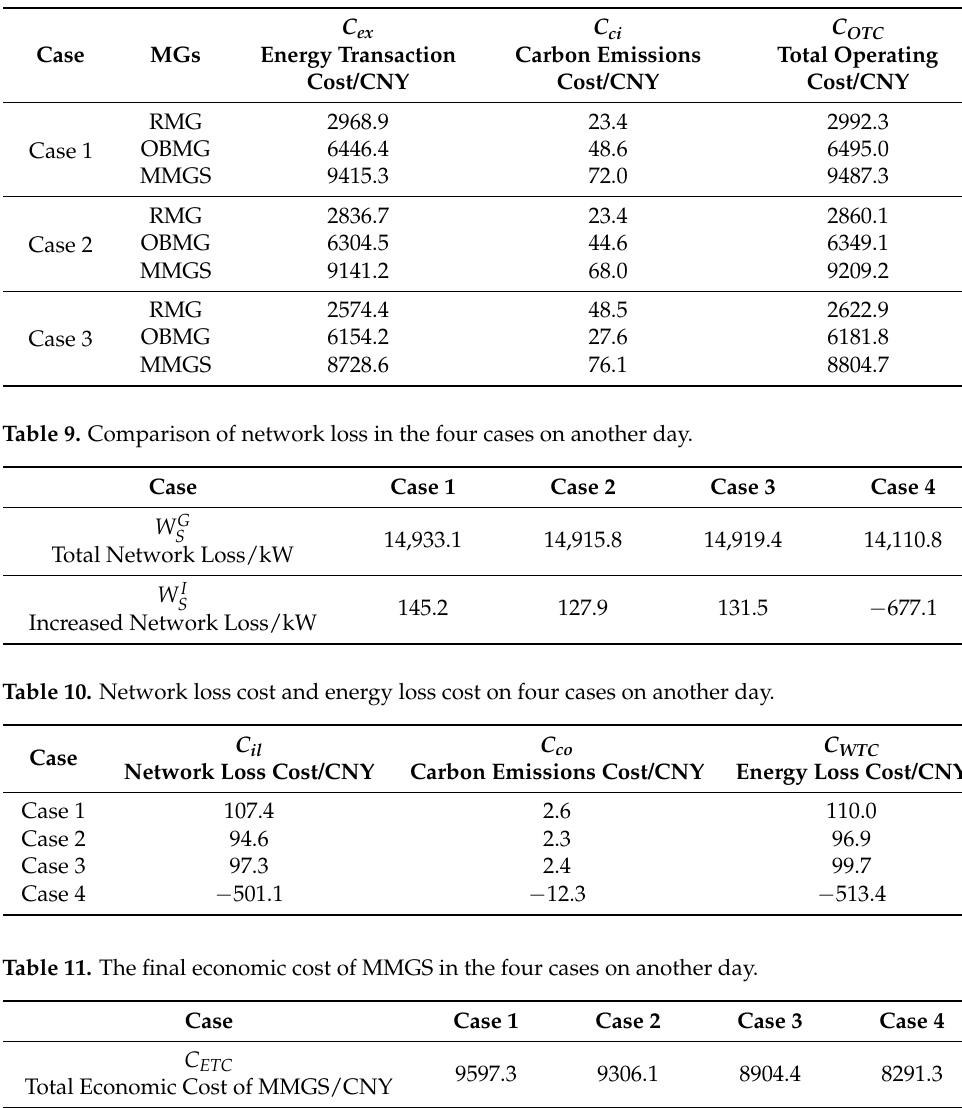
Table 8. Comparison of operating cost in three cases on another day.